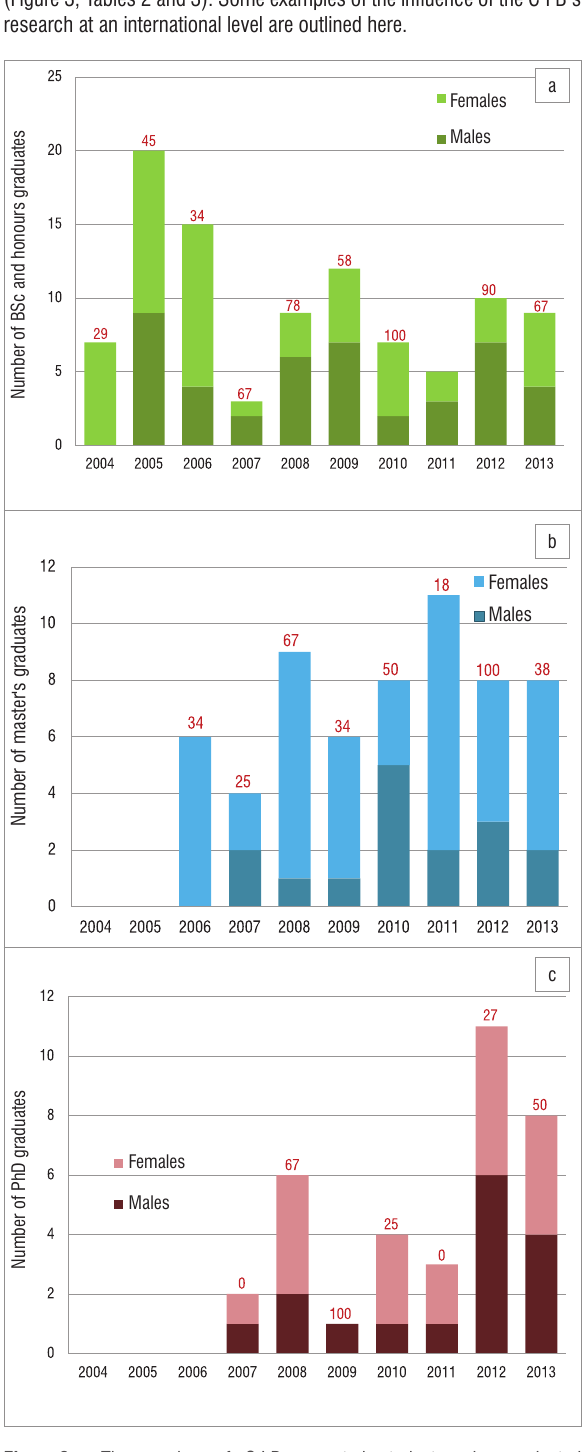
The number of C·I·B-supported students who graduated between 2004 and 2013 with (a) a 4-year BSc or honours degree, (b) master’s degree and (c) doctoral degree. Numbers above the bars indicate the percentage of black